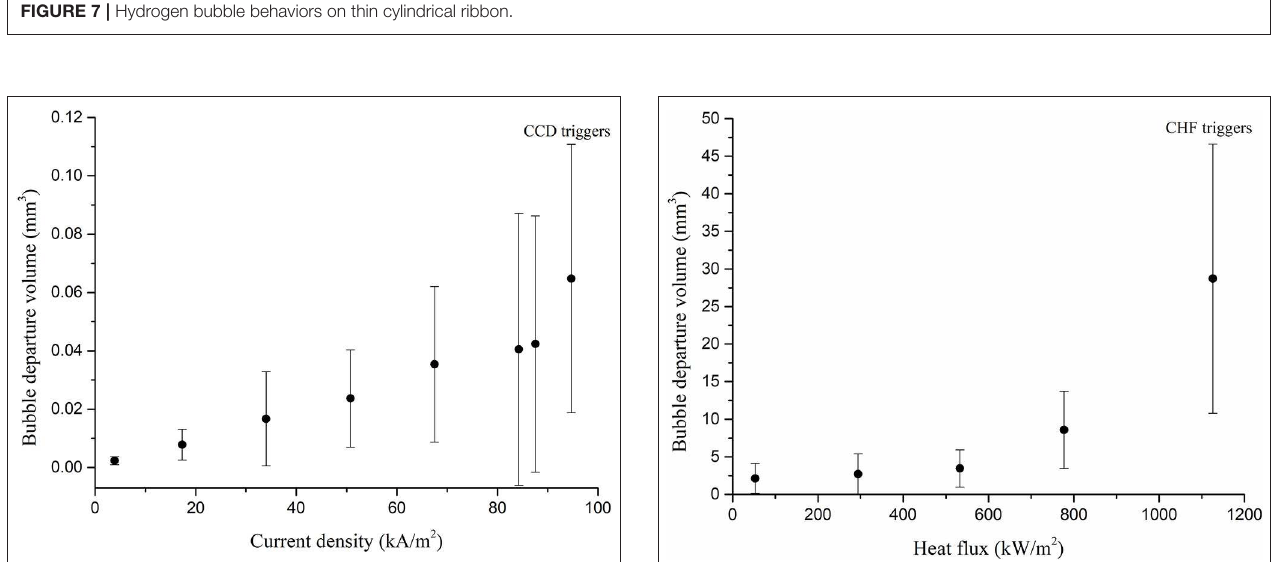
FIGURE 7 | Hydrogen bubble behaviors on thin cylindrical ribbon.